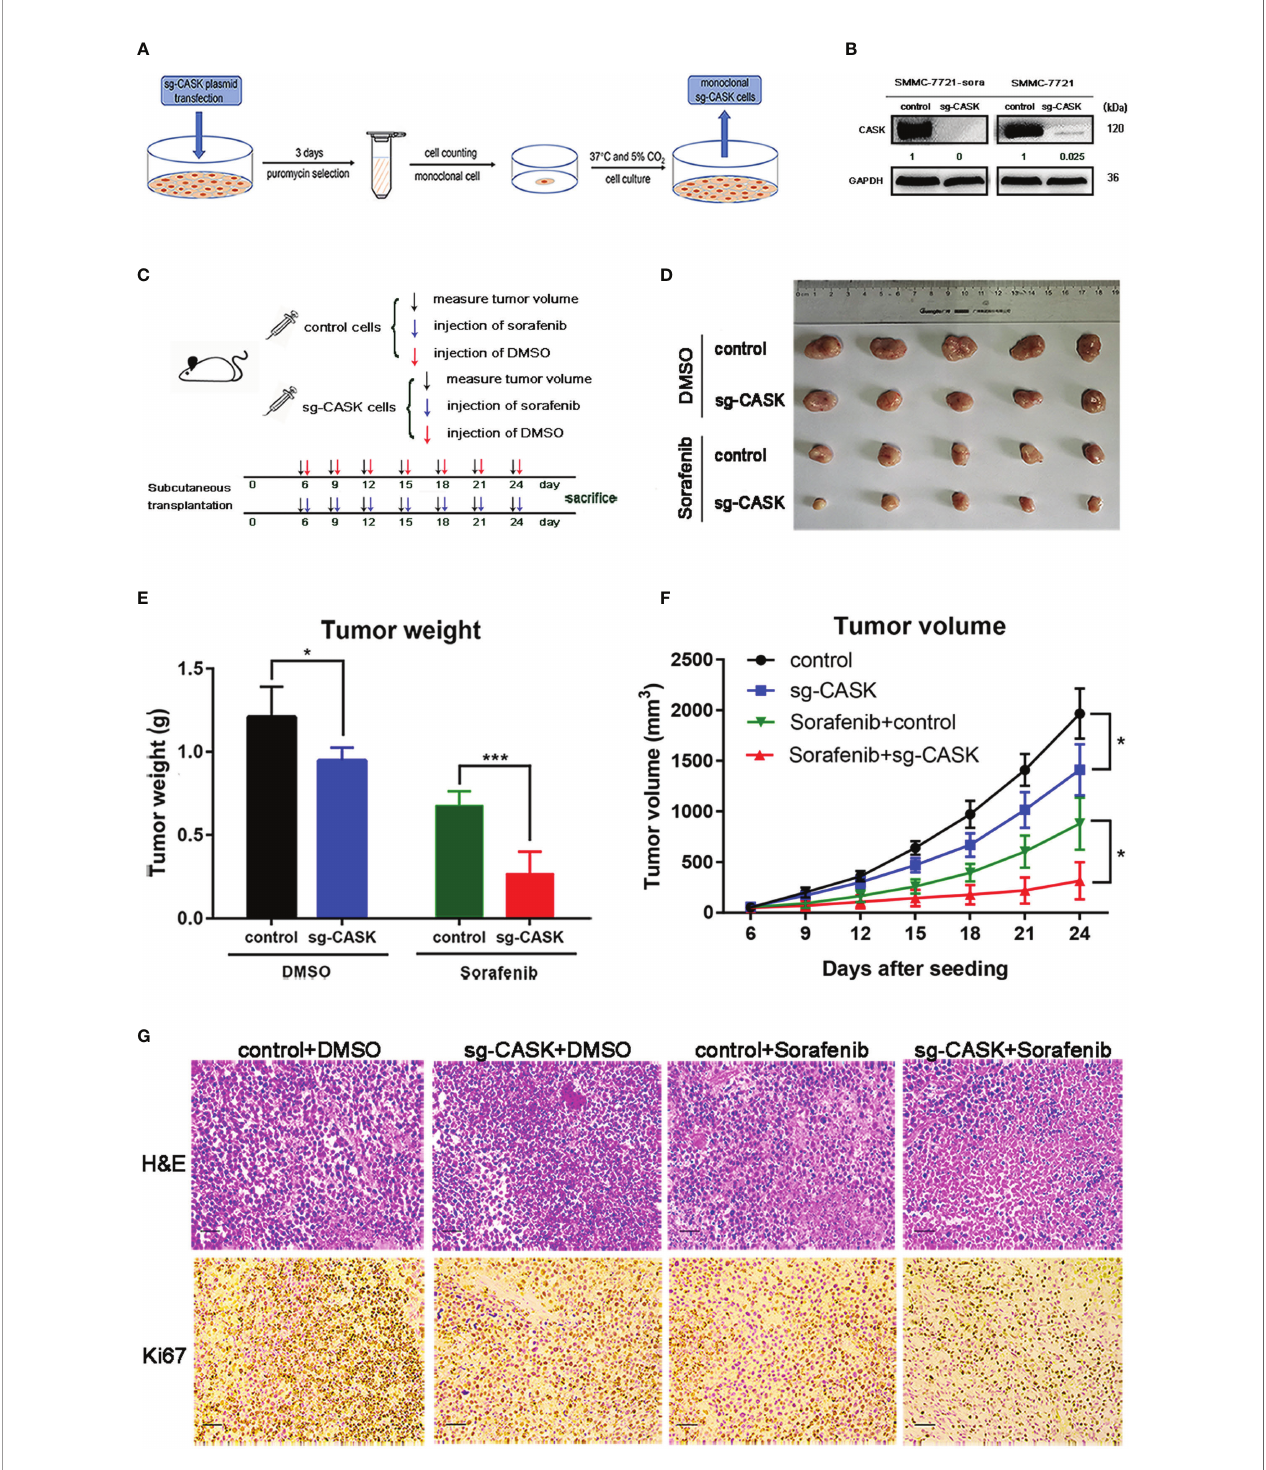
FIGURE 4 | CASK knockout suppressed tumorigenesis and sorafenib resistance of HCC in vivo . (A) The fl ow chart for screening stable CASK knockout cell lines using CRISPR Cas9. (B) The western blot analysis indicates the protein expression of CASK in SMMC-7721-sora and SMMC-7721 cell lines stably-transfected by sgRNA against CASK using CRISPR Cas9. (C) Overall work fl ow of in vivo experiments. (D – F) The subcutaneous tumor models were built by SMMC-7721-sora with stable CASK knockout cells or control cells with following treatment of DMSO or sorafenib. The tumor weights and tumor volumes were measured and quanti fi ed. (G) Representative images of tumor samples with H&E and Ki67 staining. Scale bar: 100 m M. *P < 0.05, ***P <